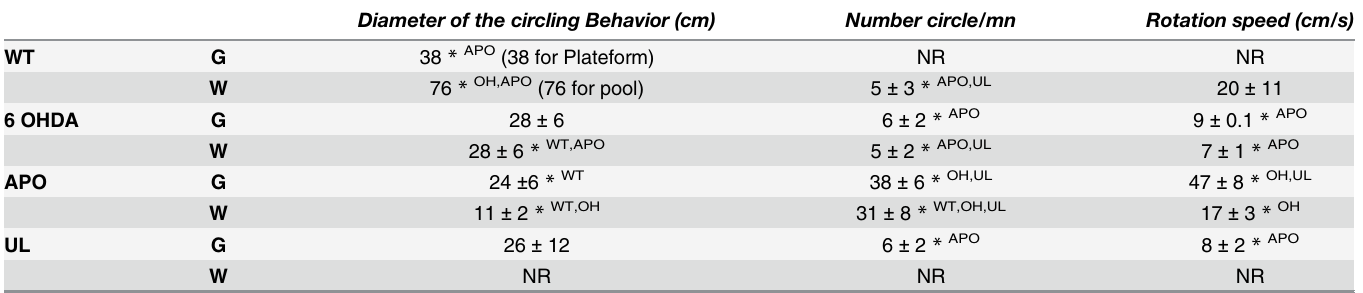
UL G W NR NR NR The mean values ( ± standard deviation) have been compared for the same support in the other rat conditions ( * Acronym in inset represent a signi fi cantly difference with other rat condition (one-way Anova with p < 0.05, and t-test). WT; Control rats, 6-OHDA; Rats with unilateral degeneration of the